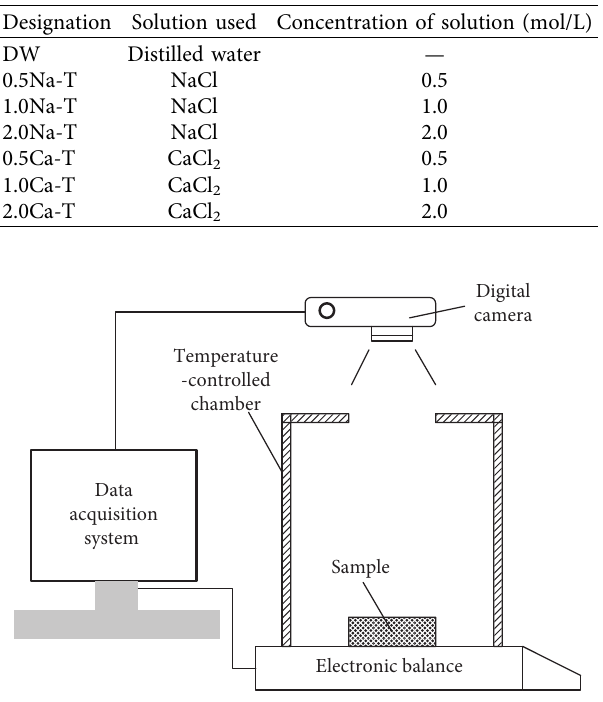
Figure 1: The setup of the desiccation test.